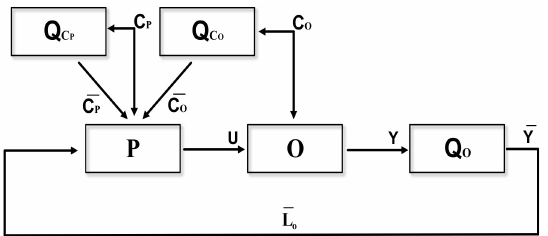
Figure 36. The process of adaptive control with a priori insufficient information about changing the parameters of the control object and the states of the